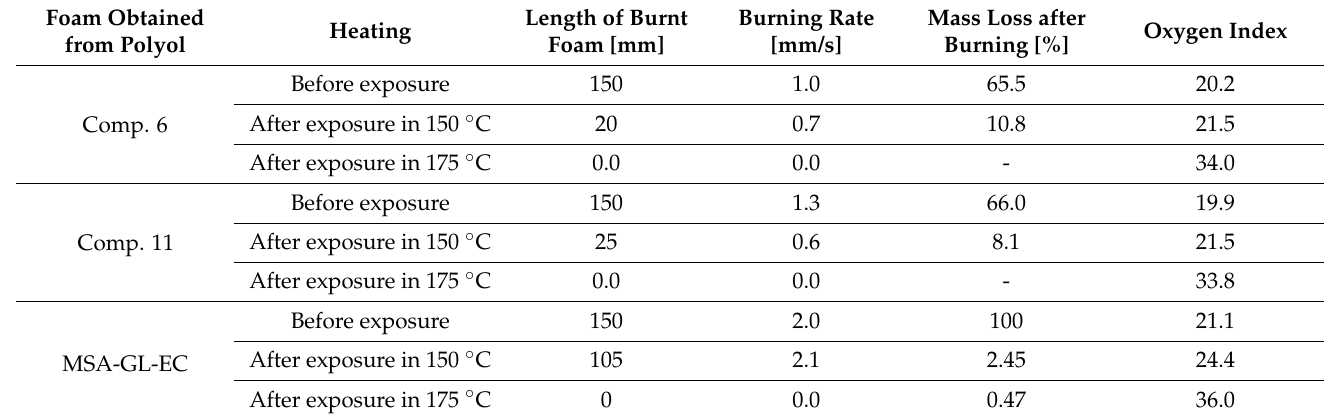
Table 9. Flame properties of